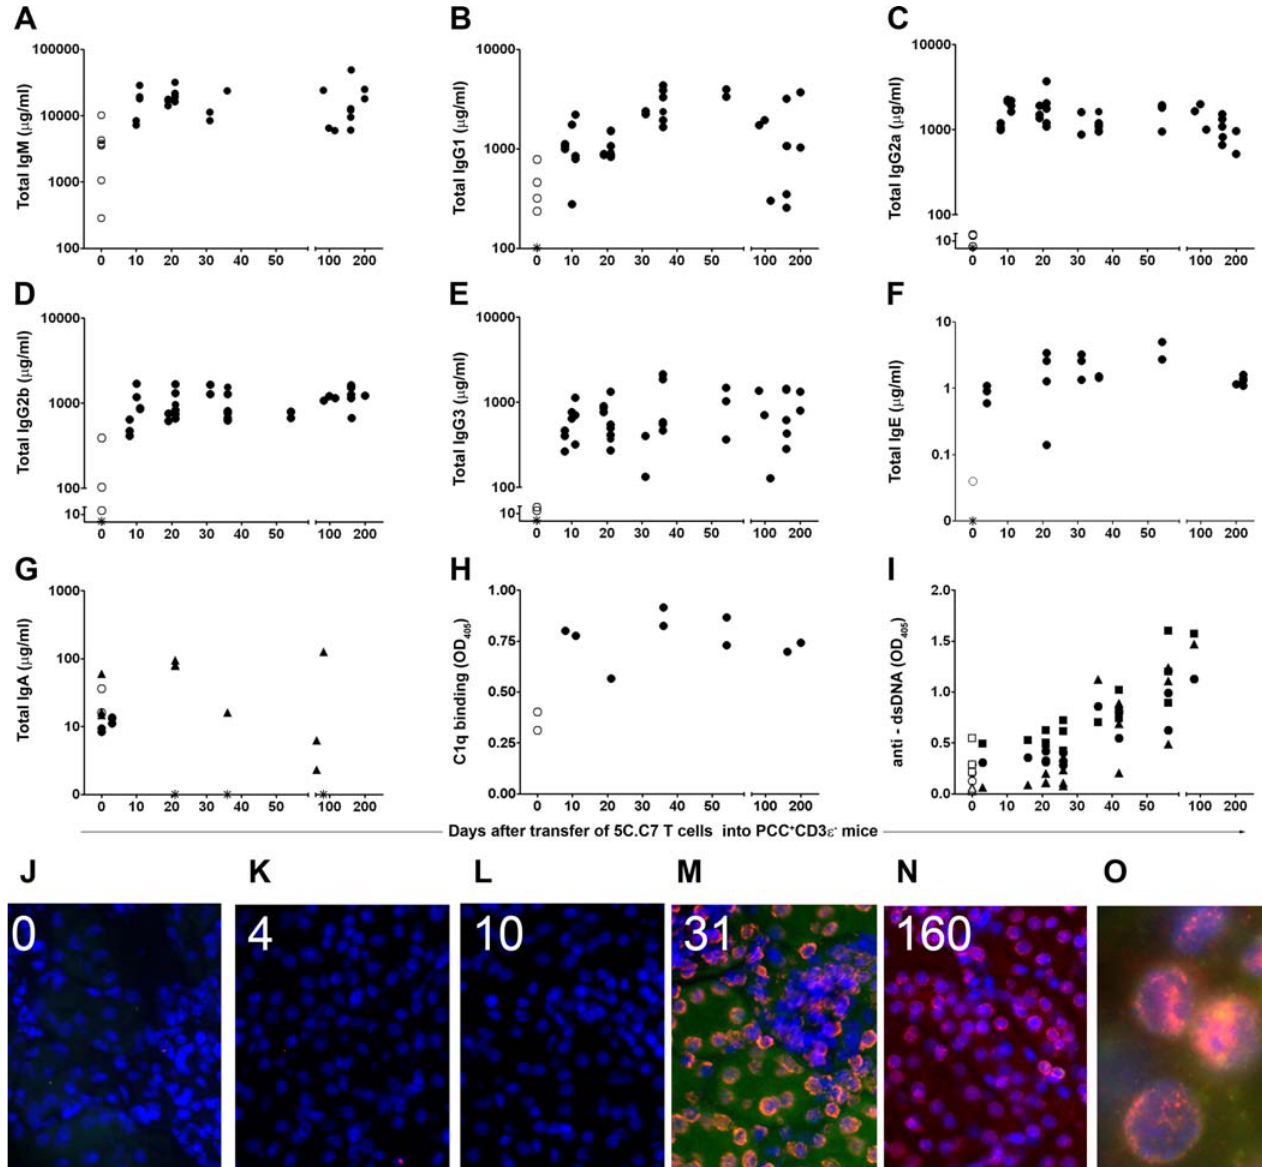
Figure 3. Polyclonal B-Cell Activation and Autoantibody Production following the Induction of T Cell Adaptive Tolerance (A–G) Total serum antibody levels of individual isotypes, measured by sandwich ELISA at different days after T cell transfer (solid circles). Open circles at time 0 represent serum measurements from normal mice, without T cell transfer. *Serum samples where the levels of the isotype was below detection [for two, four, three, three, and six samples each in (B), (C), (D), (E), and (F)]. Data in (A–E) are combined from two experiments between 4 and 60 d and two additional experiments at later time points, with two to five mice per experimental group. Three additional experiments between days 7 and 120 gave similar results. Data in (F) and (G) are from two separate experiments with three mice per time point. Serum IgA levels were below our limit of detection after the day 3 time point as indicated (*). Solid triangles in (G) represent measurements from solubilized fecal pellets. Note that the y -axes are scaled differently for (A), (F), and (G) to accommodate different absolute amounts of IgM, IgE, and IgA. (H) Increased circulating immune complexes in the serum after T cell transfer, demonstrated by a C1q binding ELISA. Each data point represents an individual mouse, whose sera were all sampled on the same day after receiving T cells at various prior times ( x -axis). (I) Titers of anti-DNA antibodies in the sera of 16 individual T cell transfer recipients sampled in two separate experiments. Optical density values obtained from isotype specific ELISAs for IgM (solid circles), IgG2b (solid squares), and IgG2a (solid triangles) are shown. Empty circles (IgM), squares (IgG2b), and triangles (IgG2a) on day 0 represent sera obtained from three normal mice, assayed in the two experiments. (J–O) Sera from mPCC,CD3 e (cid:1) / (cid:1) mice were assayed for anticellular antibodies of the IgM (green) and IgG (red) isotypes, by hybridizing with frozen tester sections of B10.A,Rag2 (cid:1) / (cid:1) kidneys. Numbers in the inset denote days after T cell transfer. (O) shows an enlarged area from (N) to illustrate speckled nuclear staining. (J) was probed with serum from a normal mPCC,CD3 e (cid:1) / (cid:1) mouse without T cell transfer. Similar sera samples from mice 4 d ( n ¼ 3) or 7 d ( n ¼ 2) after T cell transfer did not show measurable IgG or IgM anti cellular antibodies. However, all mice tested after 28 d ( n ¼ 22) scored positive for both IgG and IgM antibodies to various extents. DOI: 10.1371/journal.pbio.0040340.g003